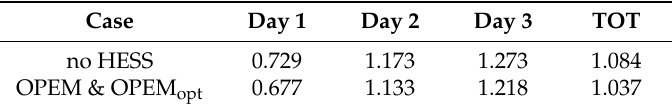
Table 6. Objective function values ( Θ , in MW RMS ).